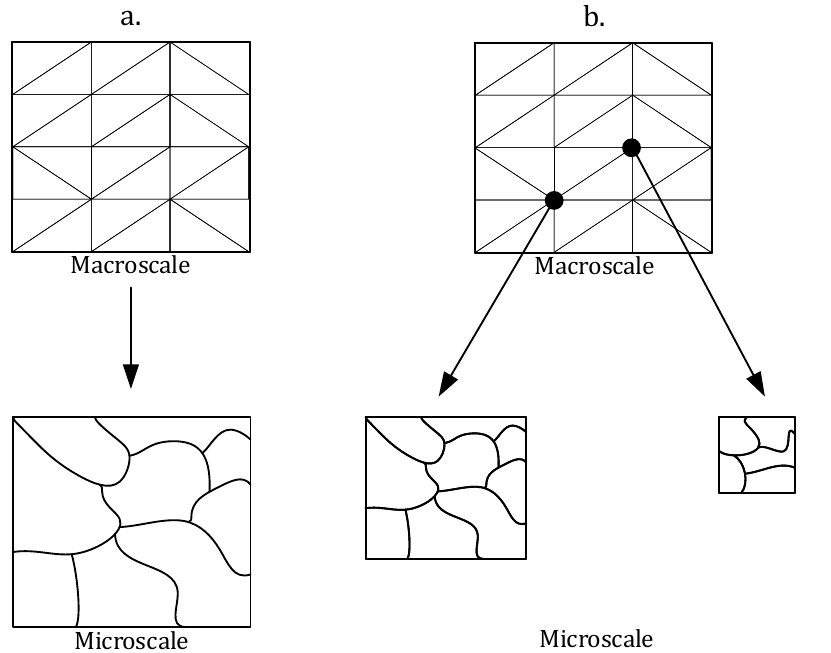
Figure 2. Types of models processed concurrently in multi-scale